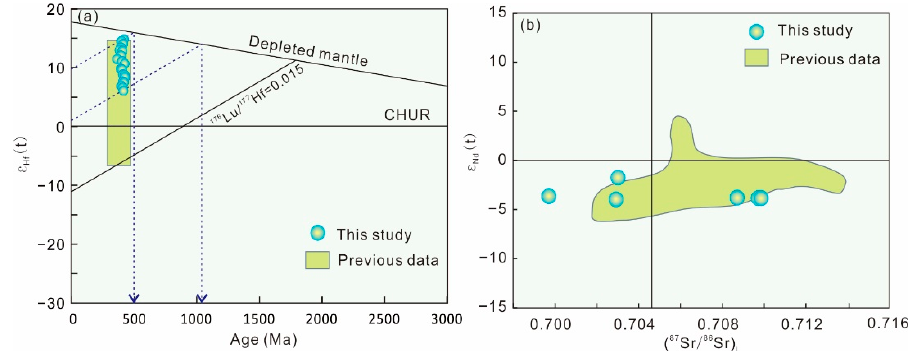
Figure 5. ( a ) In situ zircon ε Hf (t) values versus U-Pb ages and ( b ) whole-rock ε Nd (t) values versus initial 87 Sr/ 86 Sr diagrams for the volcanic rocks in the Haerdaban area (previous data are collected from [11] and its